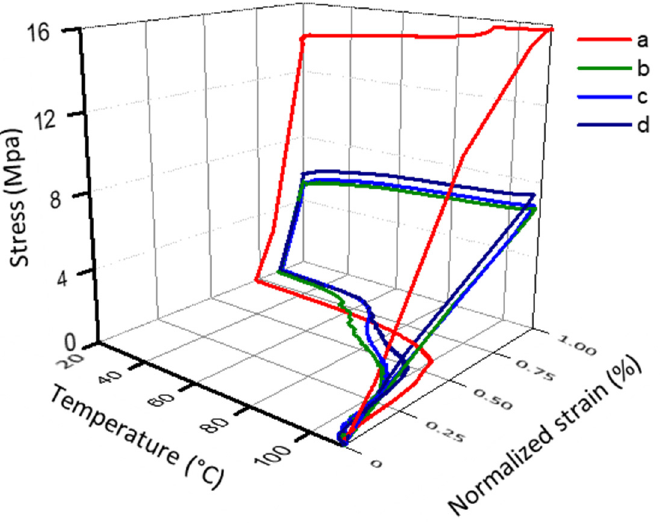
Figure 2. Resulting σ - T - ε curves obtained from cyclic thermomechanical tests of photocomposites Run a , Run b , Run c and Run d .